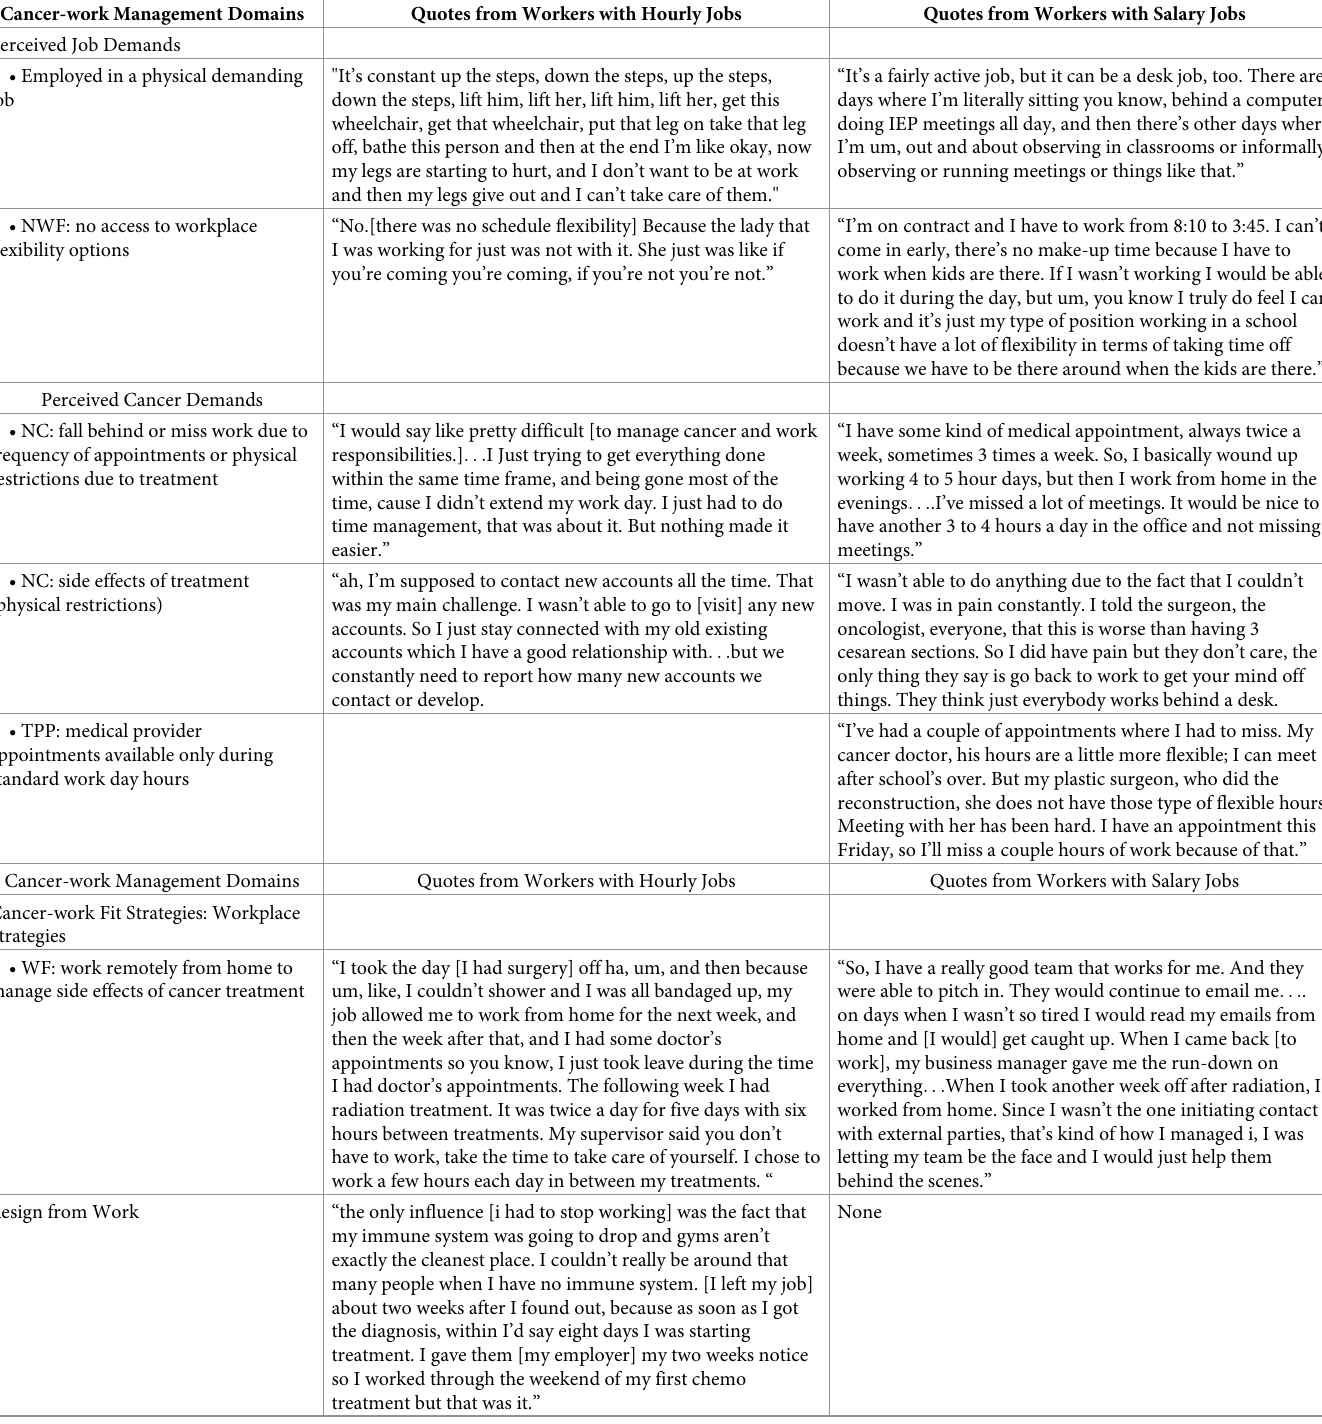
Table 5. Cancer-work management among workers with hourly and salaried jobs: A comparison of experiences (N = 48). Cancer-work Management